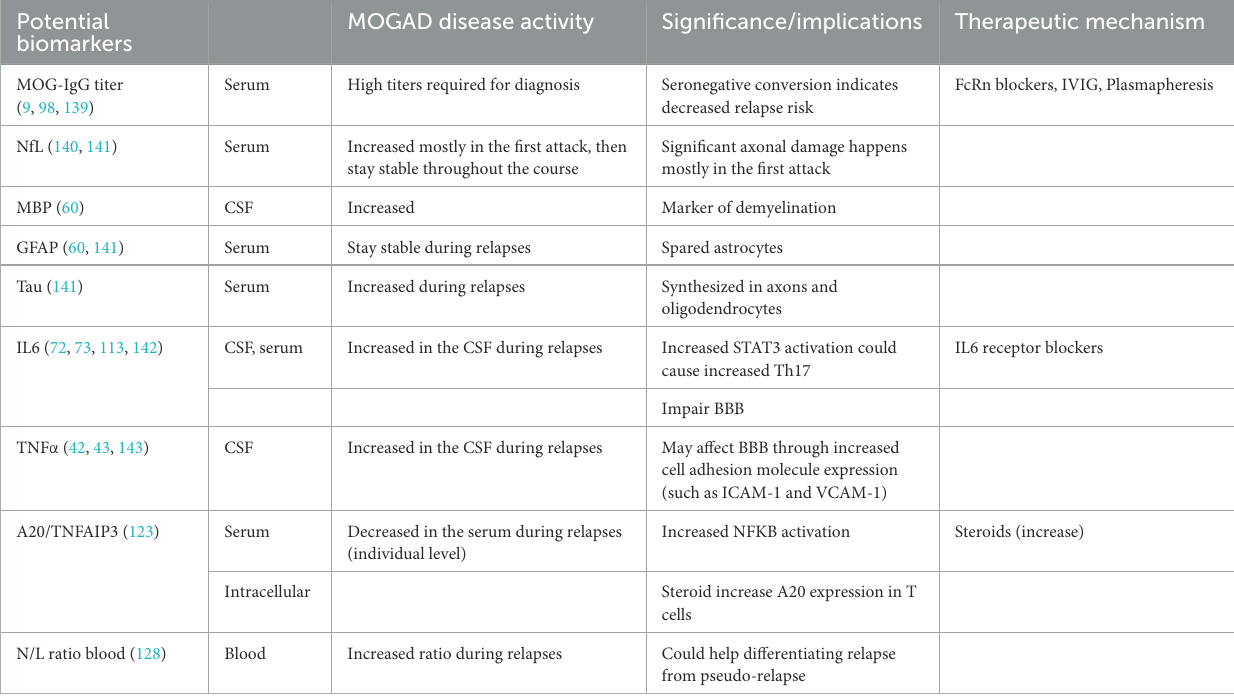
TABLE 2 Biomarkers investigated with